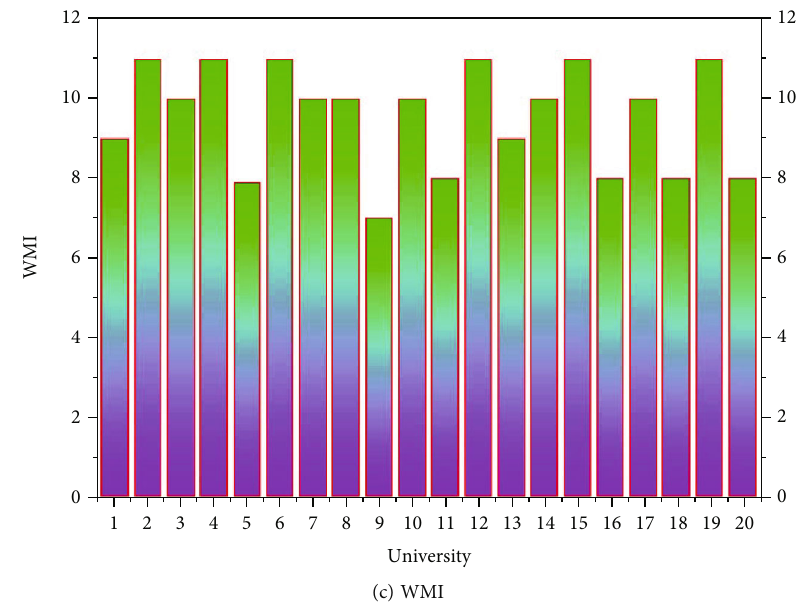
Figure 7: The results of WCI, WSI, and WMI.